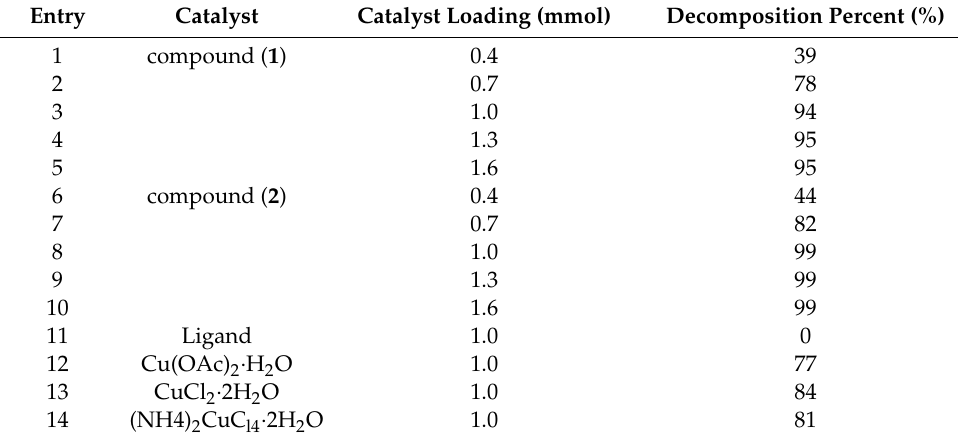
Table 2. The e ff ects of catalyst loading on the decomposition reaction of H 2 O 2 .